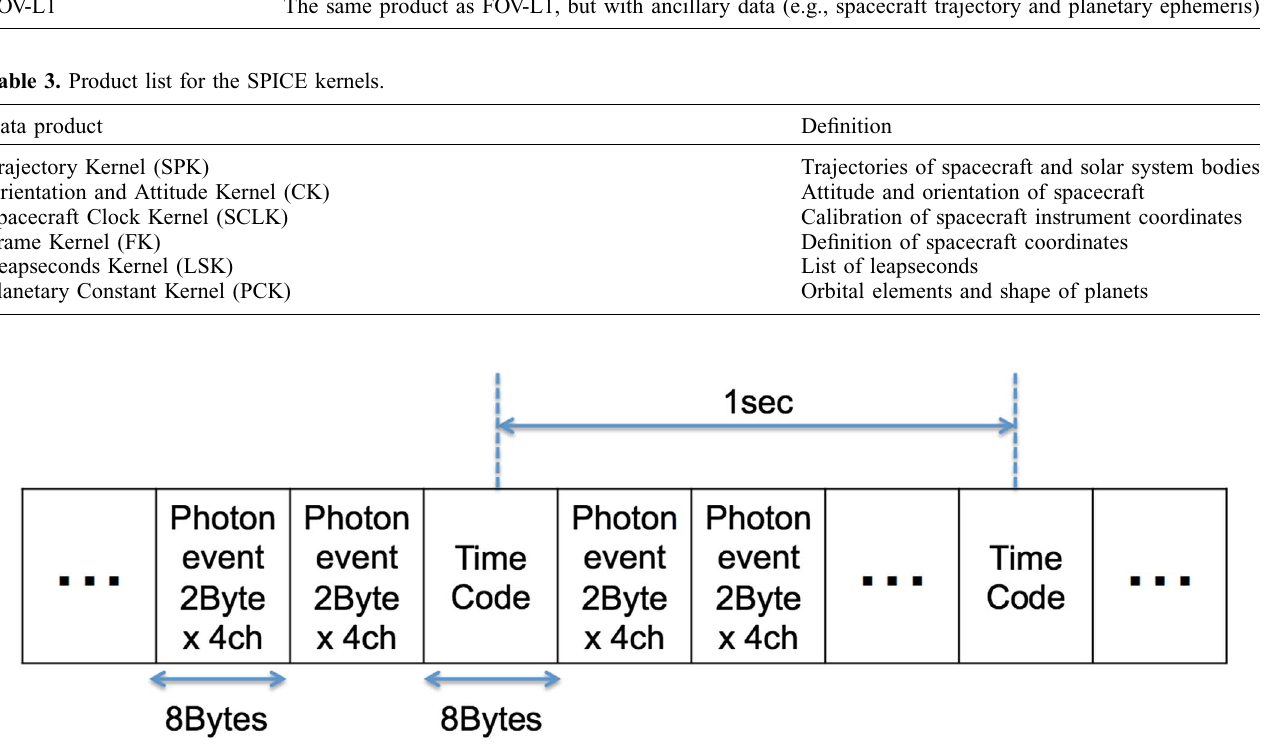
Fig. 5. Raw photon-counting data of EUV